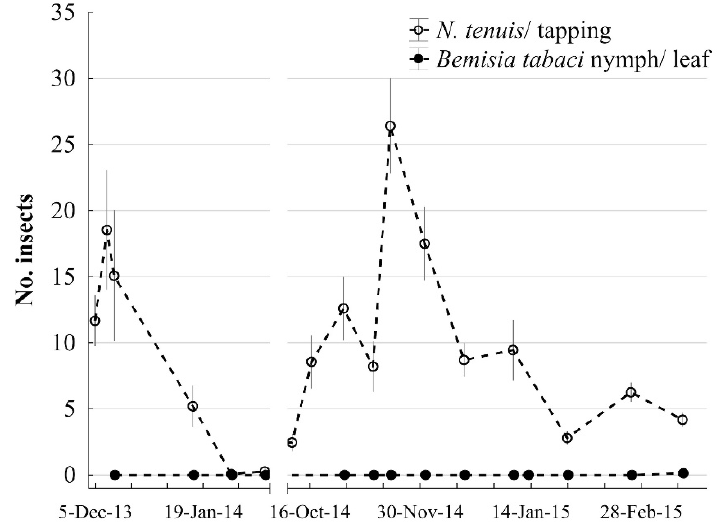
Figure 6. Seasonal incidence of N. tenuis and Bemisia sp. on tomato breeding fields. Mean (±SEM) of N. tenuis per plant (tapping) and Bemisia sp. per tomato leaf on the experimental field at Weslaco, TX, USA